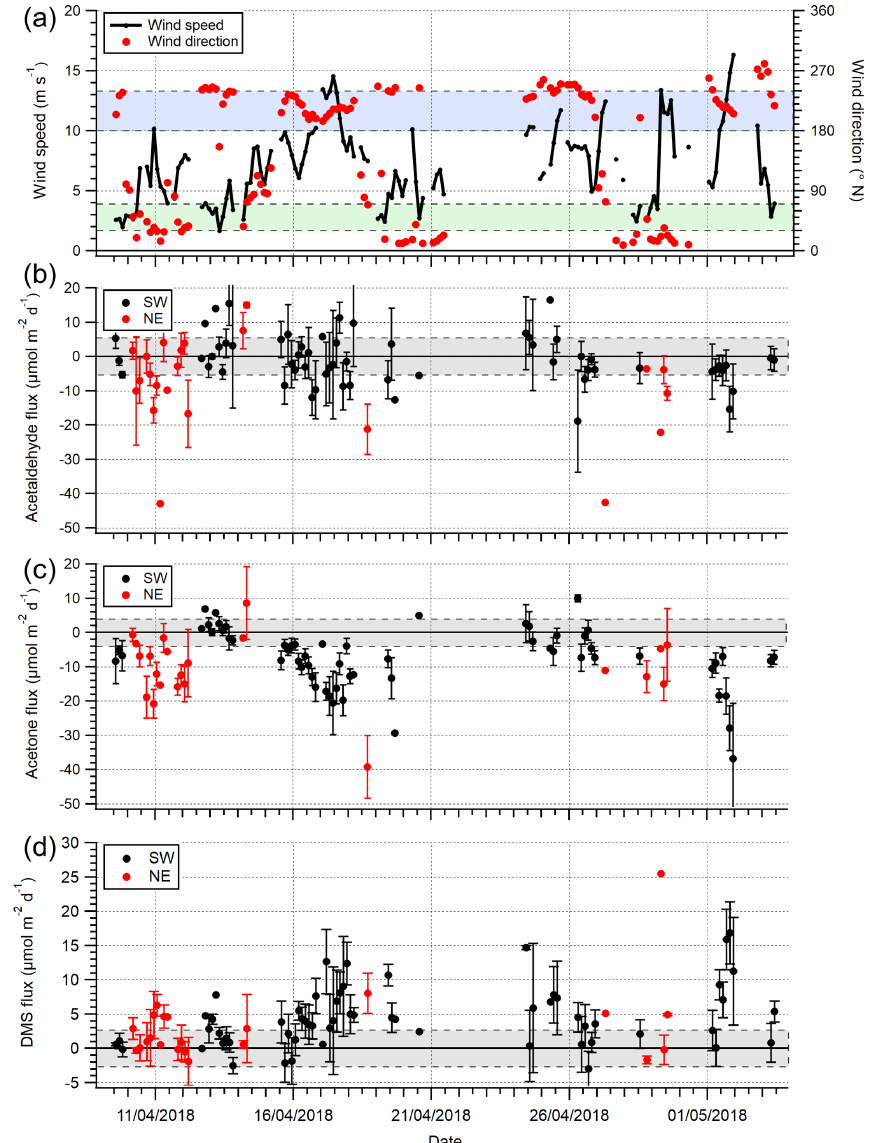
Figure 3. Time series of 3h averages of (a) wind speed ( U 10 ) and wind direction, (b) acetaldehyde flux, (c) acetone flux and (d) DMS fluxes for the open-water (180–240 ◦ N) and Plymouth Sound (30–70 ◦ N) wind sectors that met quality control criteria. Error bars are 1 standard error. The blue and green shaded zone in panel (a) represent the two wind sectors. The grey shaded zones in panels (b) – (d) represent limits of detection for 3h averages, 5.8, 4.0 and 2.7µmolm − 2 d − 1 for acetaldehyde, acetone and DMS